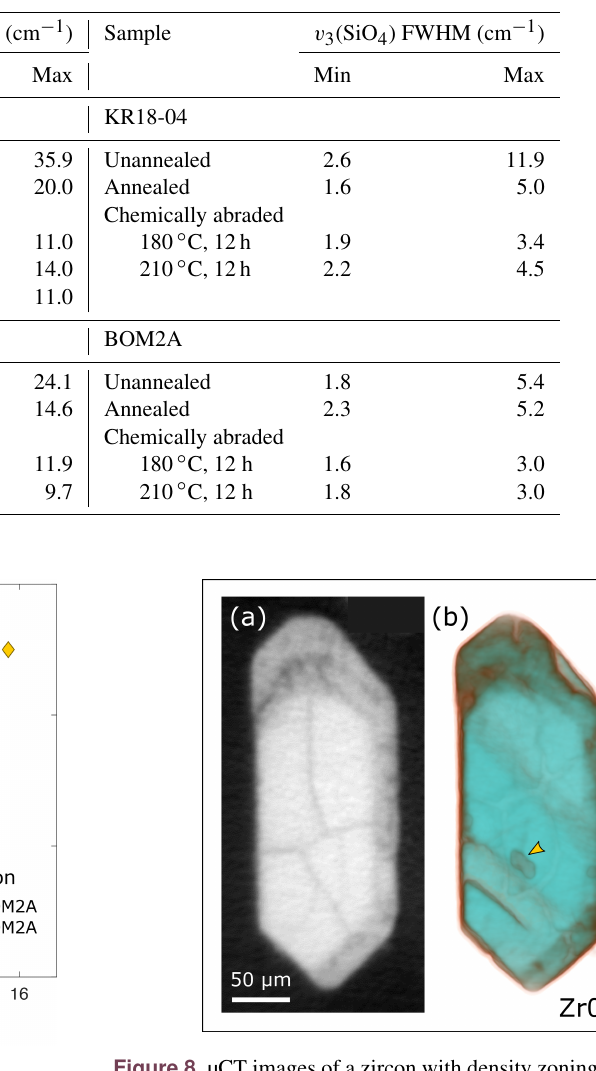
Figure 7. Raman v 3 (SiO 4 ) and E g peak width results for all chem- ically abraded zircon residues.